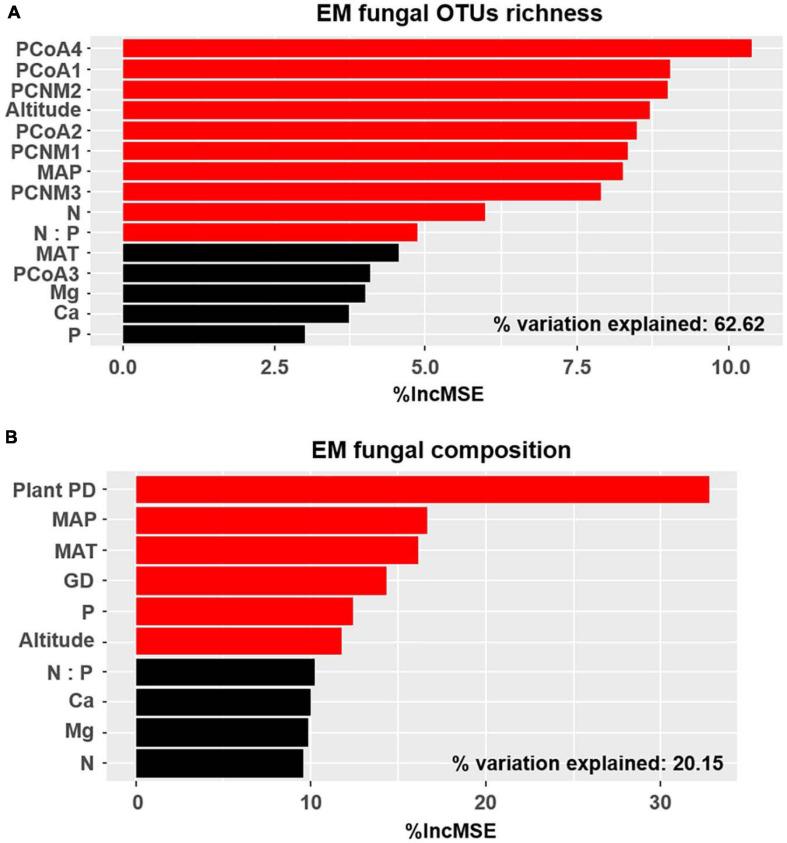
Random forest model demonstrating relative importance of host plants, spatial, soil, and climatic variables for ectomycorrhizal (EM) fungal OTU richness (A) and community composition (B) %IncMSE, % of increase of mean square error; PCoA, principal coordinate analysis of host phylogeny; PCNM, principal coordinates of neighbor matrices; MAT, mean annual temperature; MAP, mean annual precipitation; P, soil total phosphorus; N, soil total nitrogen; Ca, soil total calcium; Mg, soil total magnesium; PD, phylogenetic distance; GD, geographic distance; Significant factors are shown in red (P < 0.05) and non-significant factors are shown in black (P > 0.05).